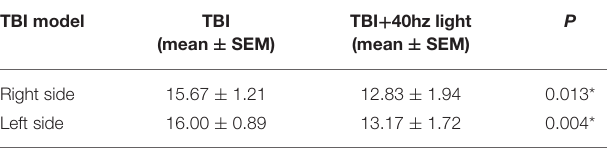
TABLE 5 | mNSS of TBI (7d) and TBI + 40hz light (7d) rats. P TBI model TBI TBI + 40hz light (mean ± SEM) (mean ± SEM) Right side 15.67 ± 1.21 12.83 ± 1.94 0.013* Left side 16.00 ± 0.89 13.17 ± 1.72 0.004* mNSS for two types of TBI models were calculated. P-values correspond to one-way ANOVA between TBI (7d) and TBI + 40hz light (7d). Data are expressed as mean ± SEM. * P <